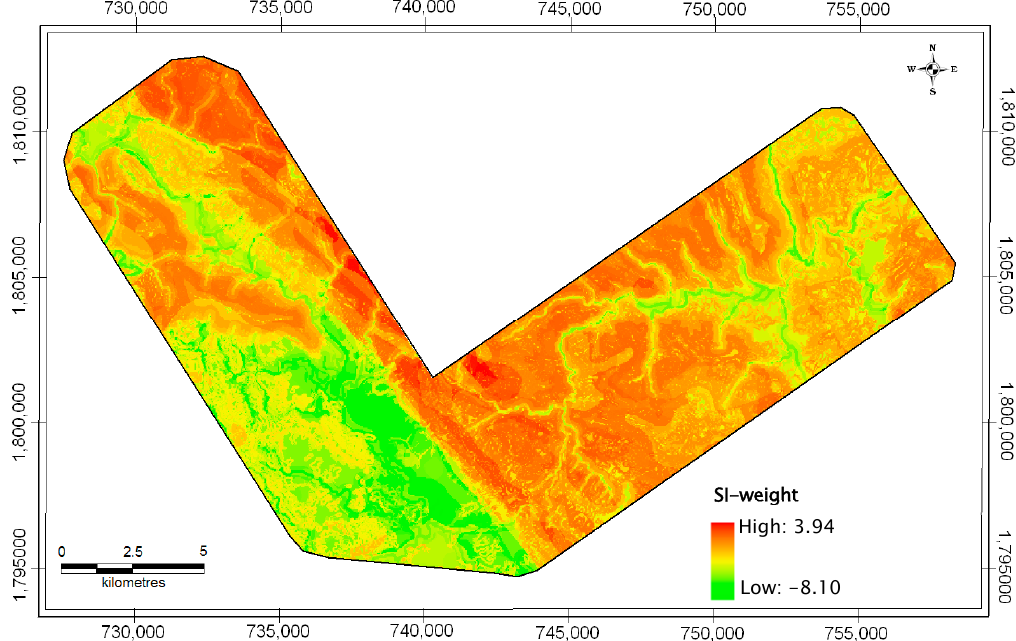
Figure 2. Landslide susceptibility map based on the statistical index model.